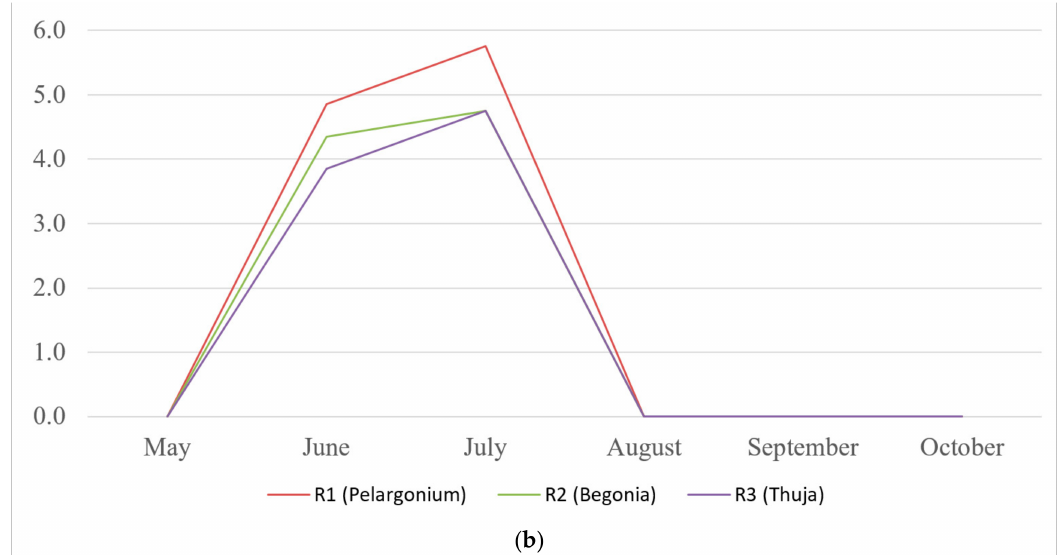
Figure 2. Irrigation of plants in the months of the experiment, ( a ) in greenhouse, ( b ) in